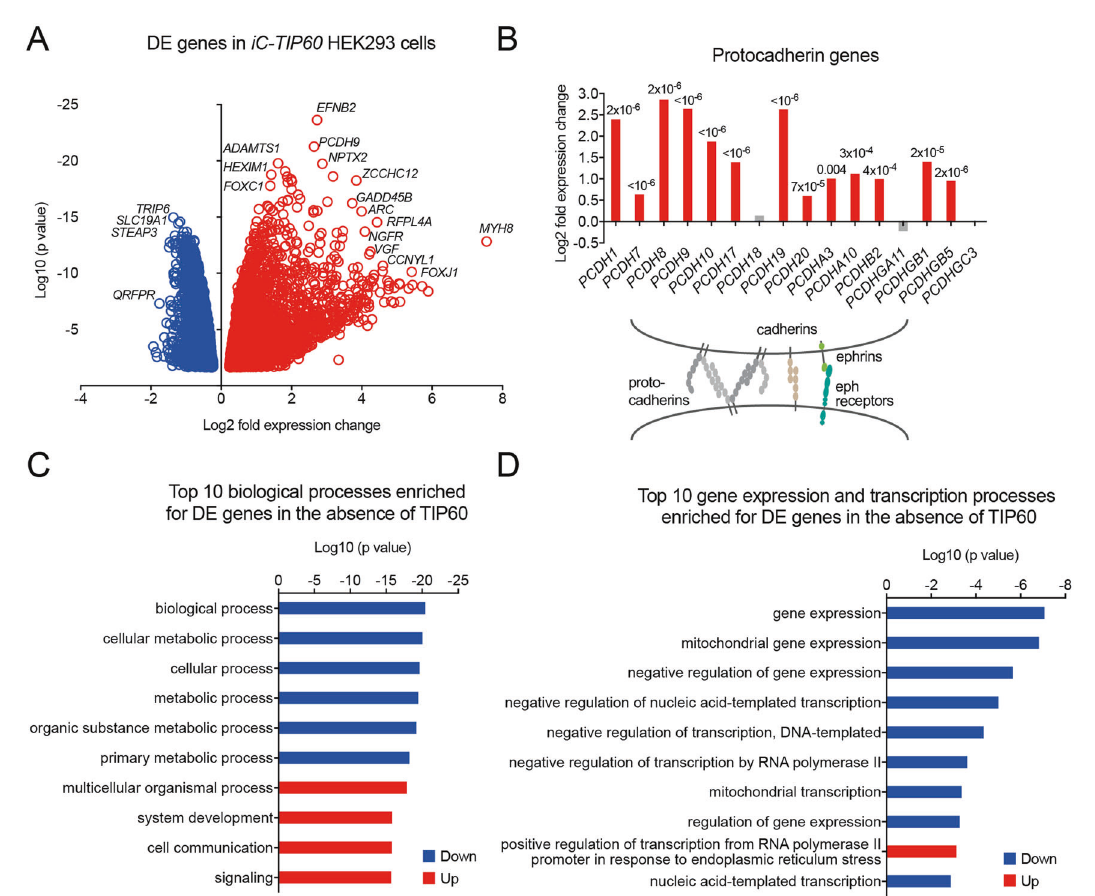
Fig. 5 TIP60 is required for normal gene expression in mouse cells. A – D RNA-seq results of Tip60 iKO/iKO ;ERT2 vs. Tip60 + / + ;ERT2 control MEFs after 3 days and 5 days ( A , combined analysis) or after 3 days of 4-OHT treatment B – D to induced Tip60 deletion ( n = 3 cell isolates from individual embryos per genotype). A Mean-difference plot showing the log2 fold change vs. average log2 counts-per-million of each mRNA in Tip60 iKO/iKO ;ERT2 MEFs vs. Tip60 + / + ;ERT2 control MEFs after treatment for 3 and 5 days with 4-OHT. Differentially expressed genes (FDR < 0.05) are indicated. B Heatmap of the top 50 differentially expressed (DE) genes by FDR in Tip60 iKO/iKO ;ERT2 vs. Tip60 + / + ;ERT2 control MEFs after 3 days of 4-OHT treatment. C Expression level changes of the Trp53 (p53) gene and p53 target genes and cyclin-dependent kinase inhibitor genes Cdkn2b and Cdkn2c in the absence of TIP60. D Top 10 biological processes (GO terms) and gene expression and transcription processes (GO terms) enriched for genes differentially expressed (DE) in the absence of TIP60 in MEFs. RNA-seq results of Tip60 iKO/iKO and control